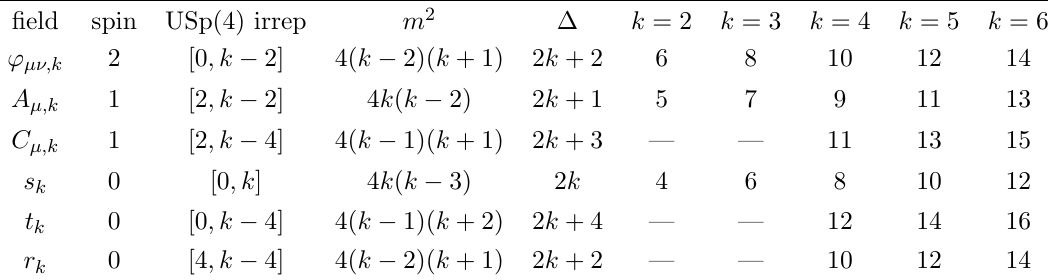
Table 1. KK modes contributing to exchange diagrams allowed by R-symmetry selection